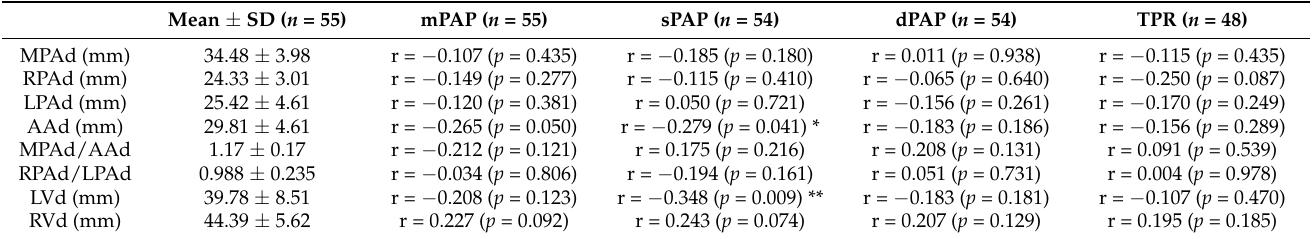
Table 4. Correlation between pulmonary artery pressure and CTPA features by Spearman test.